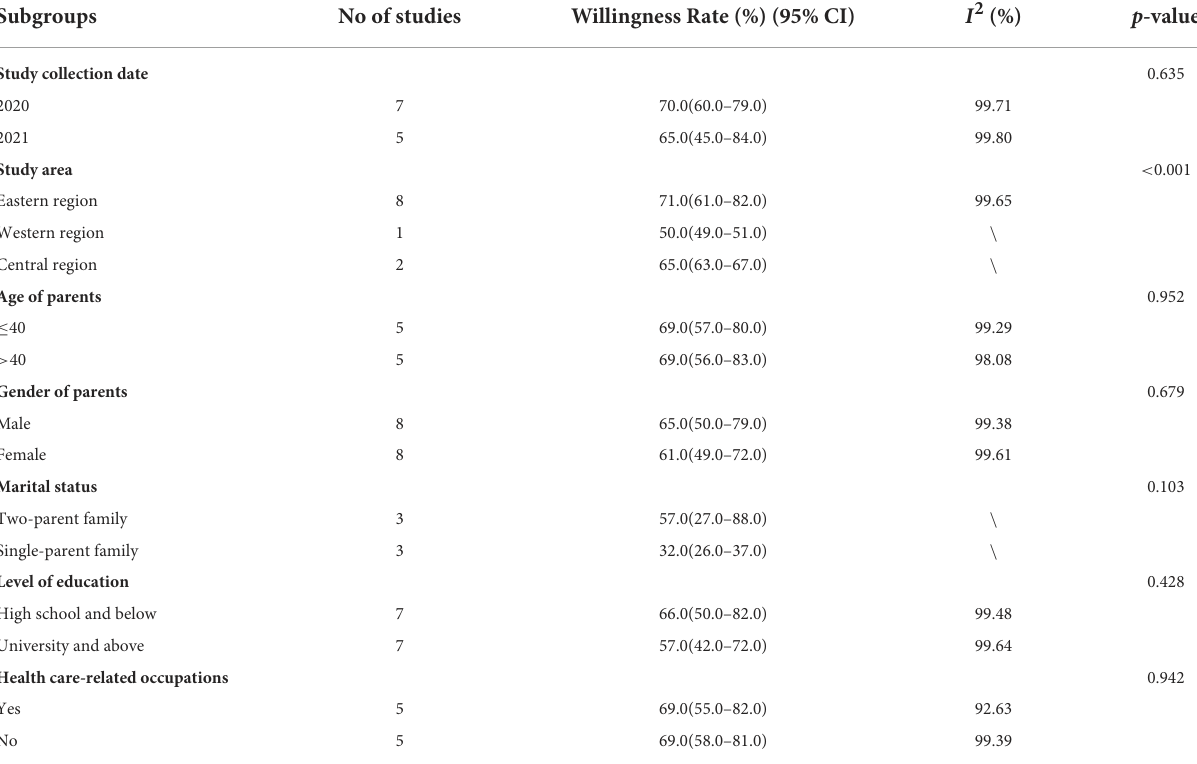
TABLE 2 The results of subgroup